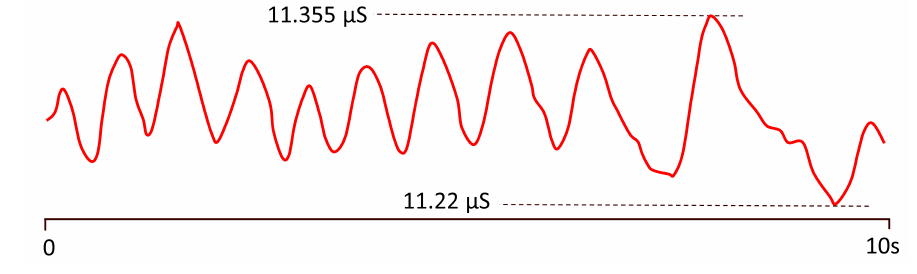
Figure 7. Fluctuations of skin conductance registered in